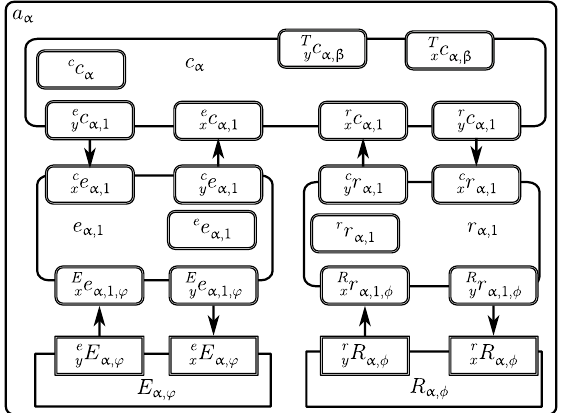
Figure 5. General structure of a window agent a α ; where α is the name of the agent producing the window on the screen, β is the name of the agent with which a α communicates, φ is a set of information presentation boxes of a window agent a α (such as text fields) and ϕ is a set of action grabbers of a window agent a α (such as buttons). The following pairs exist: α = pGUI and β = prez, α = visionGUI and β = vision, α = aGUI_! and β = audio (where ω ∈ { init,user,cmd,ctrl } ).